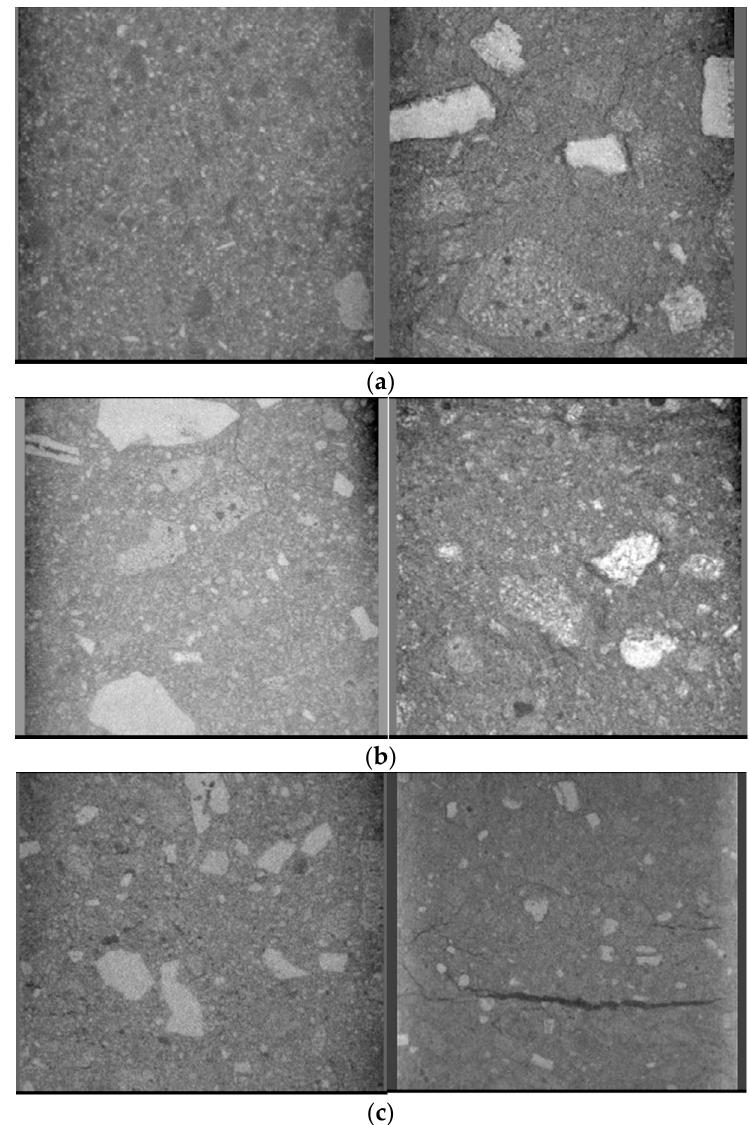
Figure 11. Distribution of pores in the original ( left ) and reduced ( right ) brex; ( a ) lime-bonded; ( b ) cement-bonded brex; ( c ) brex with magnesium sulfate based binder, magnification 64.